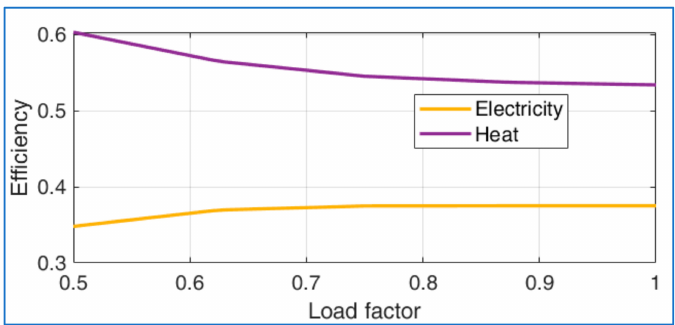
Figure 2. Part-load e ffi ciencies of the